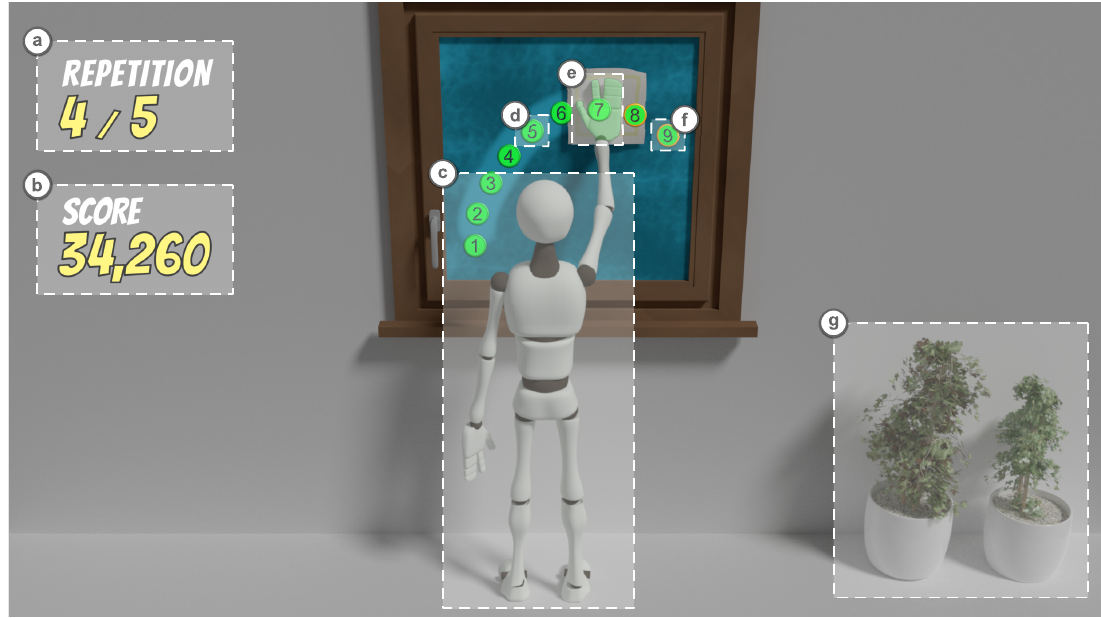
Figure 4. Example of exergame: ( a ) Current repetition. ( b ) Achieved score. ( c ) Patient avatar (actor). ( d ) Sequence of game mechanics after interacting (actor). ( e ) Patient’s joint for exercise; green denotes sequence actors sequence with which the joint must interact. ( f ) Sequence of game mechanics that still needs interaction (actor). ( g ) Animated decorative elements